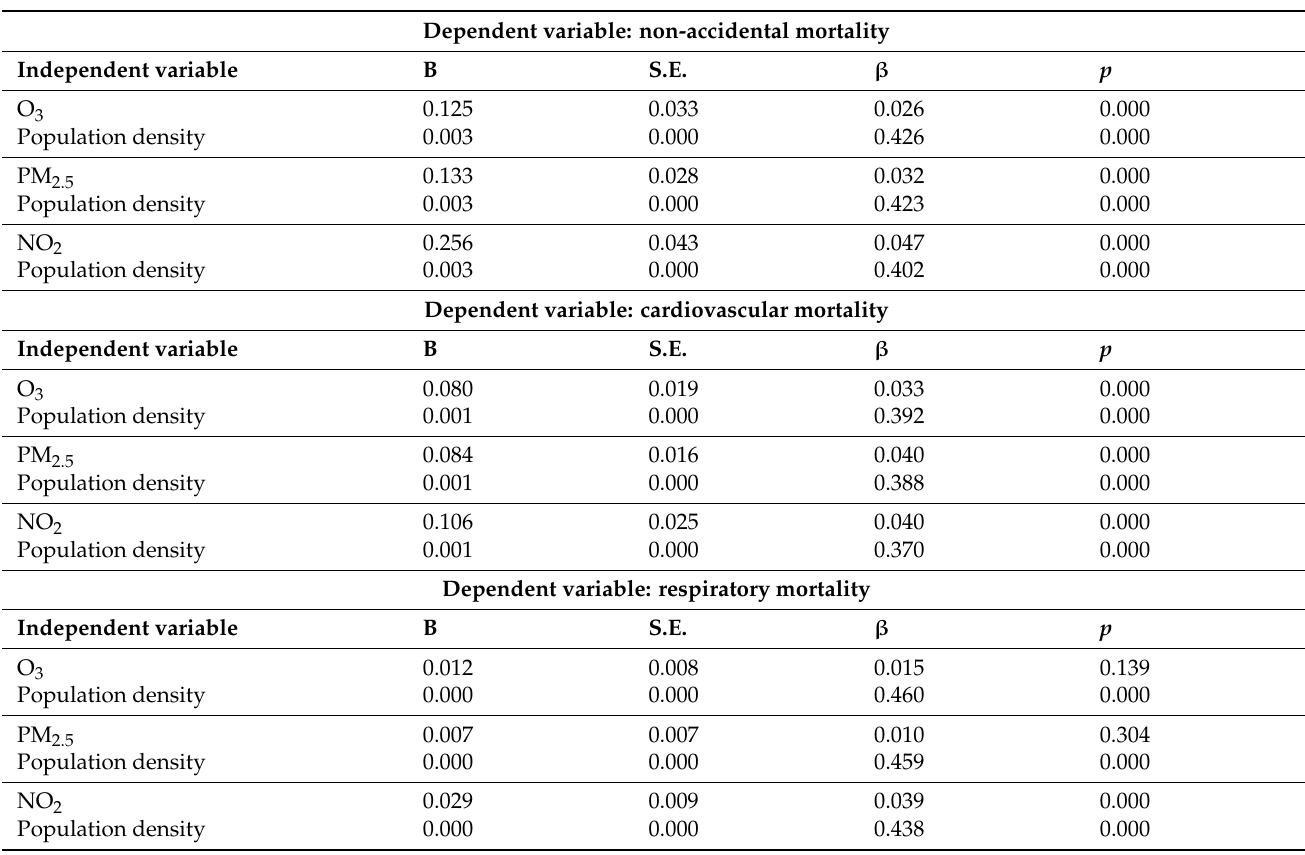
Figure 4. Correlation coefficient ( n = 17,715). Table 3. Results of regression